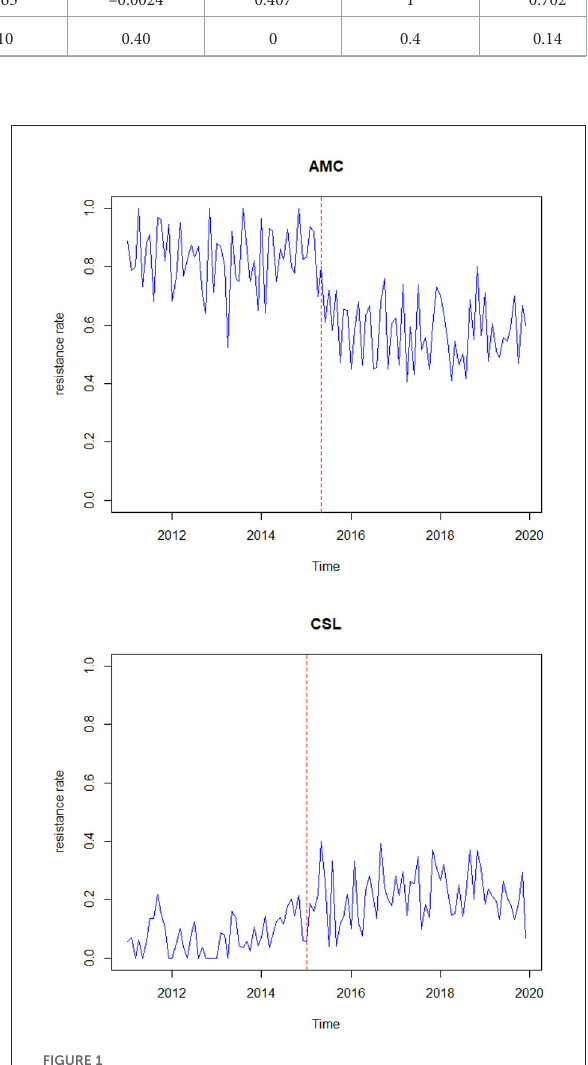
FIGURE1 Time plot of proportion of E. coli in blood resistant to antibiotics AMC and